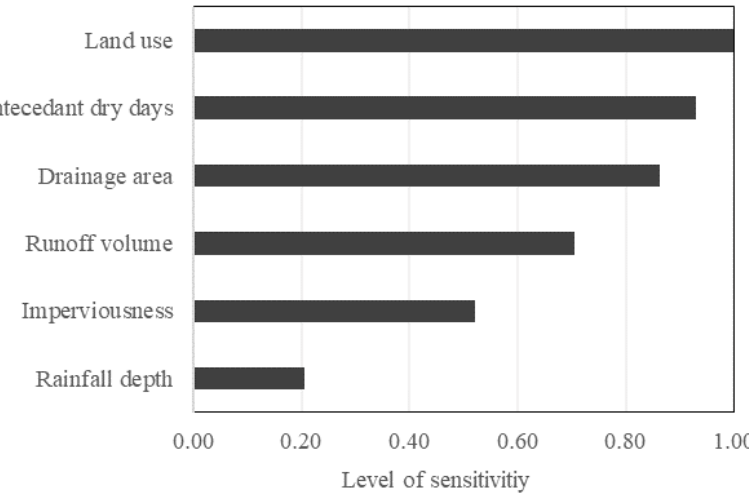
Figure 11. Sensitivity analysis results of AdB.